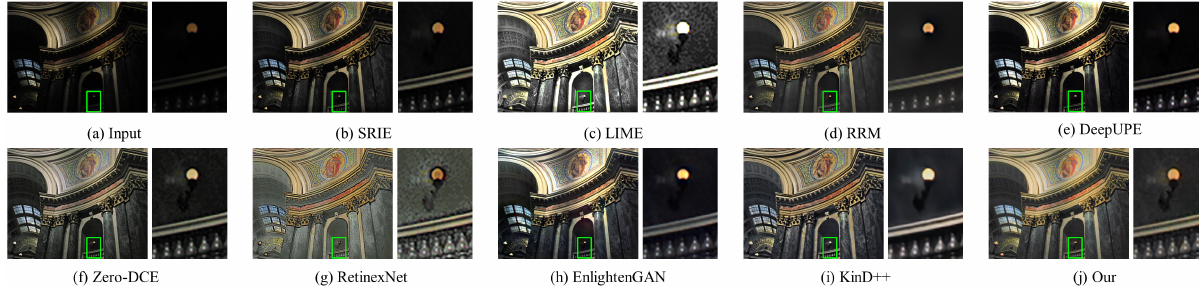
Figure 6. Visual comparison of low-light image enhancement on an image from the MEF